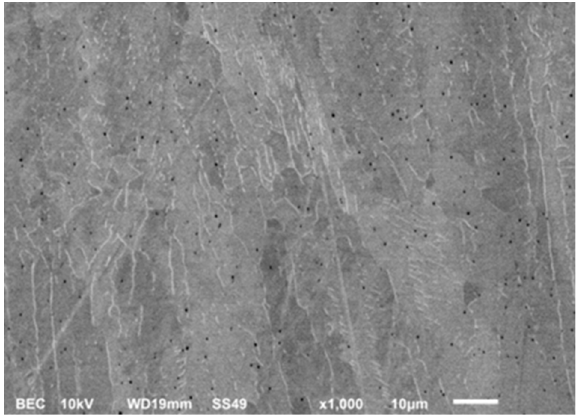
Figure 16. SEM image made with backscattered electron contrast of the as built sample with bright ferrite phases at the grain boundaries, grey austenite grains, and small pores.